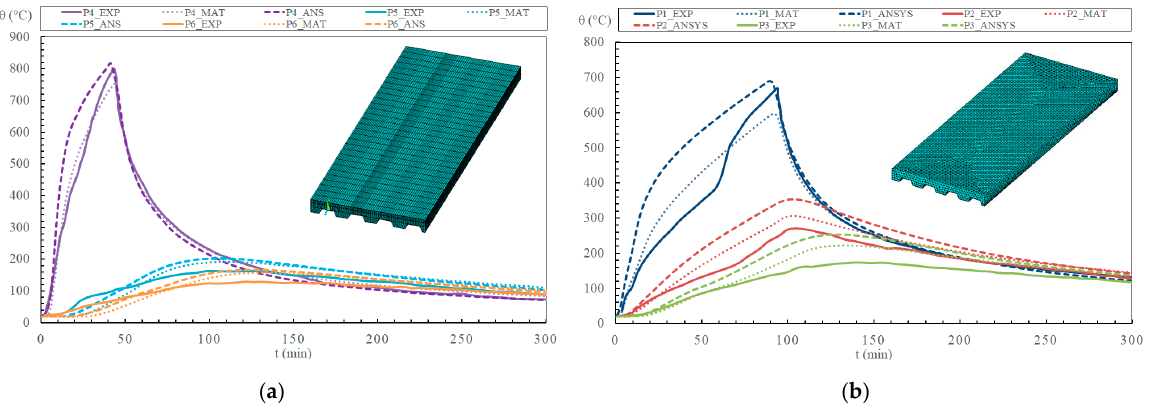
Figure 6. Numerical model validation using MATLAB and ANSYS: ( a ) Points P1, P2 and P3; ( b ) Points P4, P5 and P6.